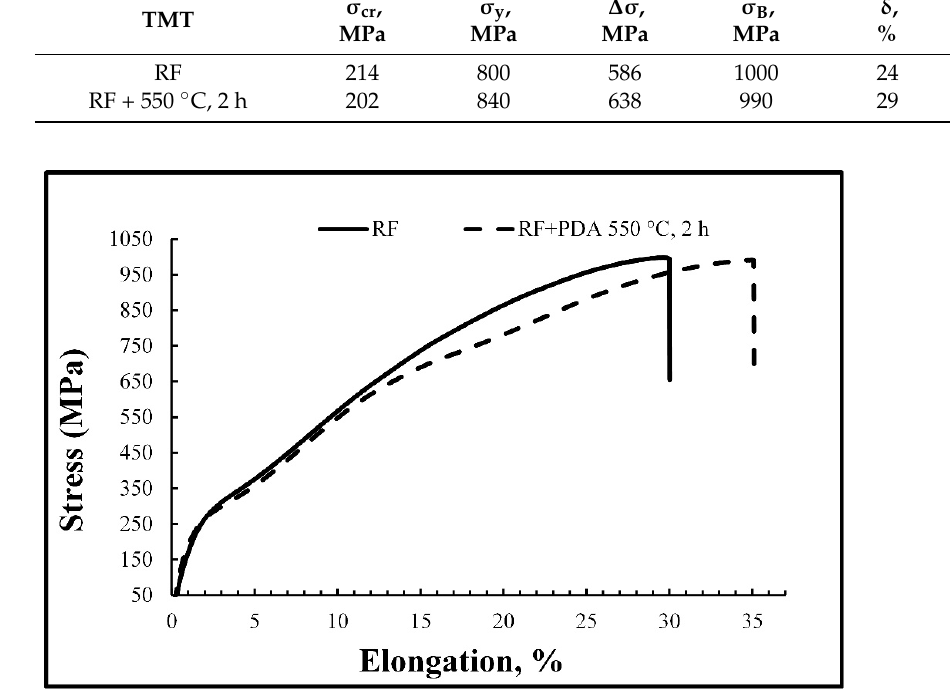
Figure 9. Representative stress–strain diagrams of TiNiHf rods after RF and RF + PDA at 550 °C for 2h. 2